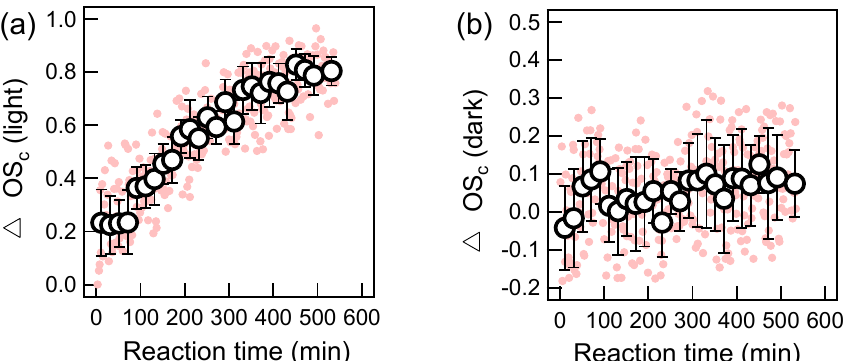
Figure 5. Temporal variations the oxidation states (OS c ) during OH-mediated photochemical oxidation ( a ) and dark oxidation ( b ) (note in each plot, the first pink point is zero; the first black circle is the average of the first 7 pink points, namely the 10.5 min average value; other black circles are average values of every 12 pink points, namely the 18 min average; the error bar is one standard deviation).